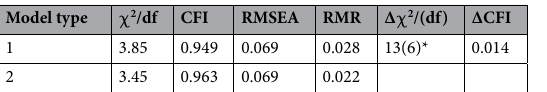
Table 3. Fit statistics of tested models and result of χ 2 difference test. * p <